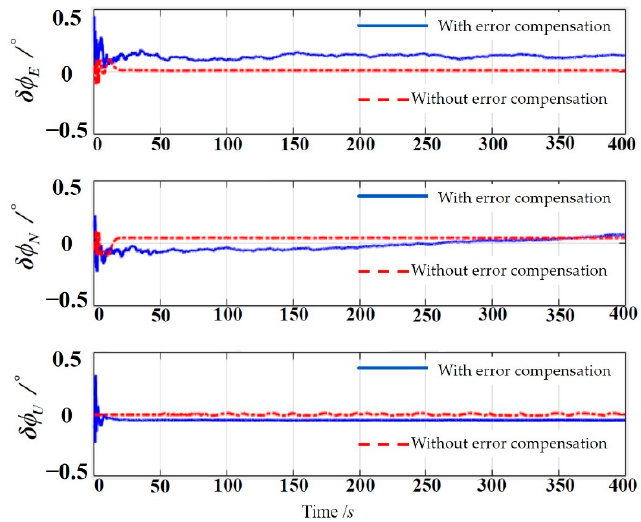
Figure 13. The comparison of attitude angle error. Table 2. Maximum attitude angle errors.